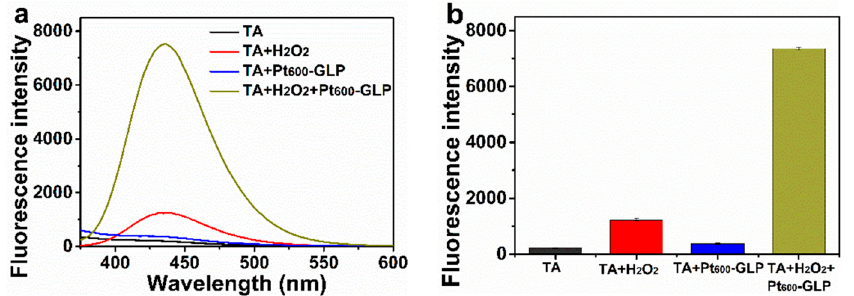
Figure 9. ( a ) Fluorescence spectra and ( b ) histograms of fluorescence intensity of TA + H 2 O 2 + Pt 600 - GLP NCs group and control groups after 12 h. The final concentrations of TA, H 2 O 2 , and Pt were 0.3 mM, 20 mM, and 49 μ M,